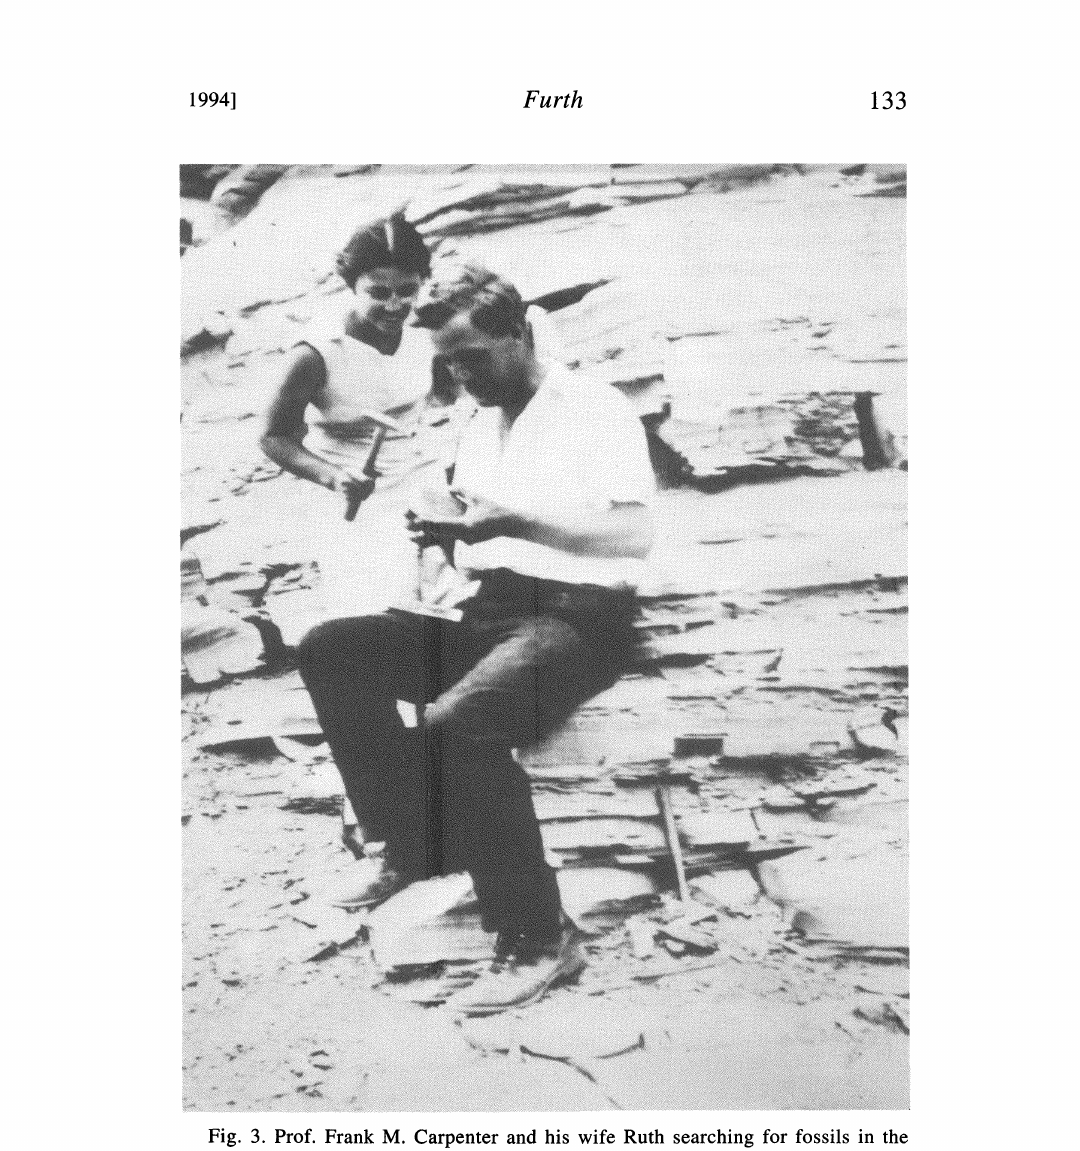
Fig. 3. Prof. Frank M. Carpenter and his wife Ruth searching for fossils in the Eocene Green River shales at Watson, Utah, July